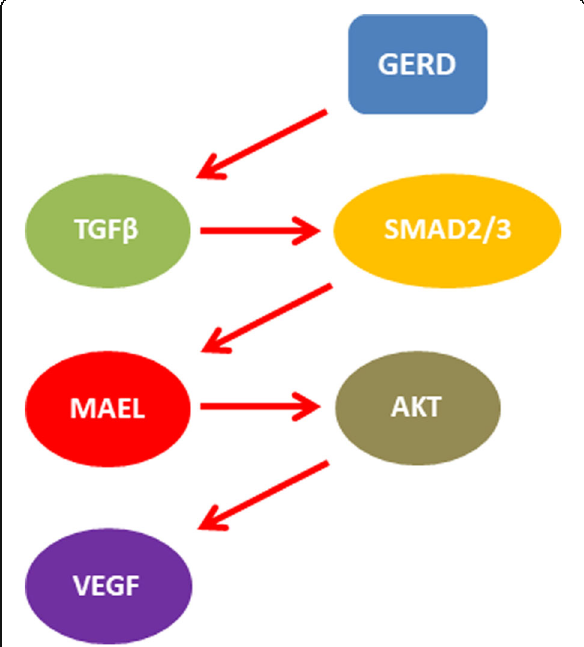
Fig. 2 Probable mechanism of higher MAEL levels in lower esophagus